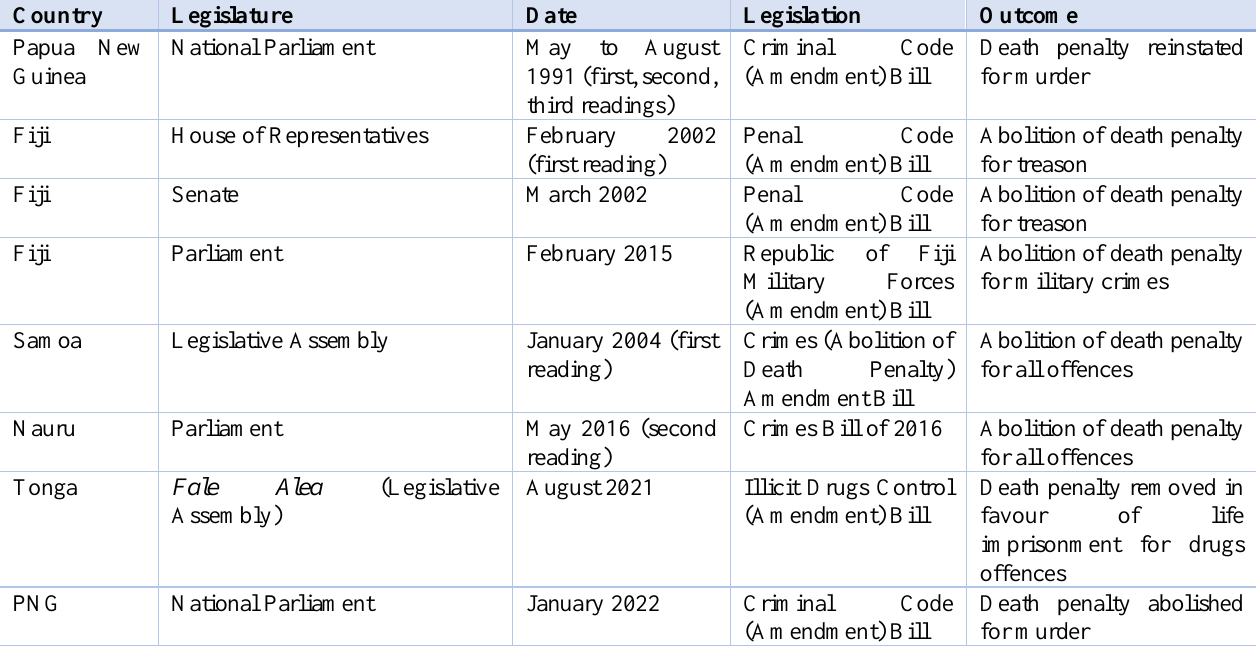
Table 2. Legislative debates on the death